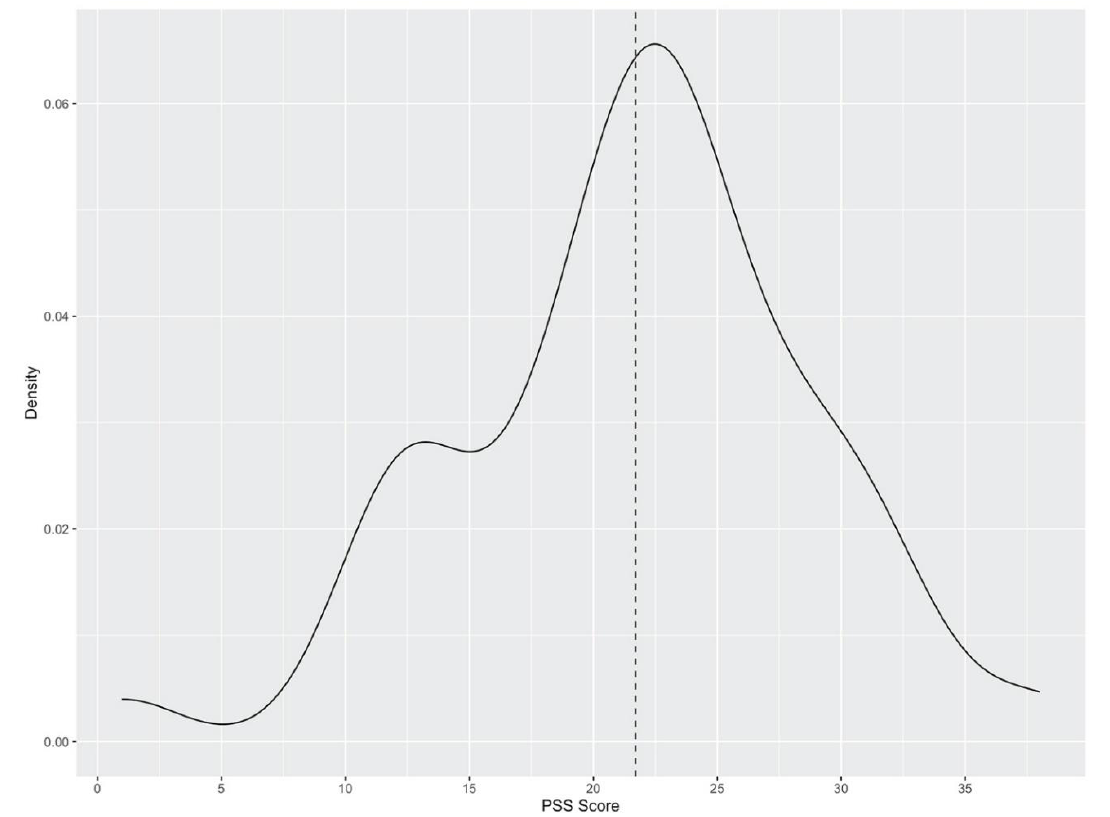
Figure 1. Distribution of Perceived Stress Scores (PSS-10) among participants (observations, n = 42); mean ± SD of PSS-10 = 21.7 (±7.1).